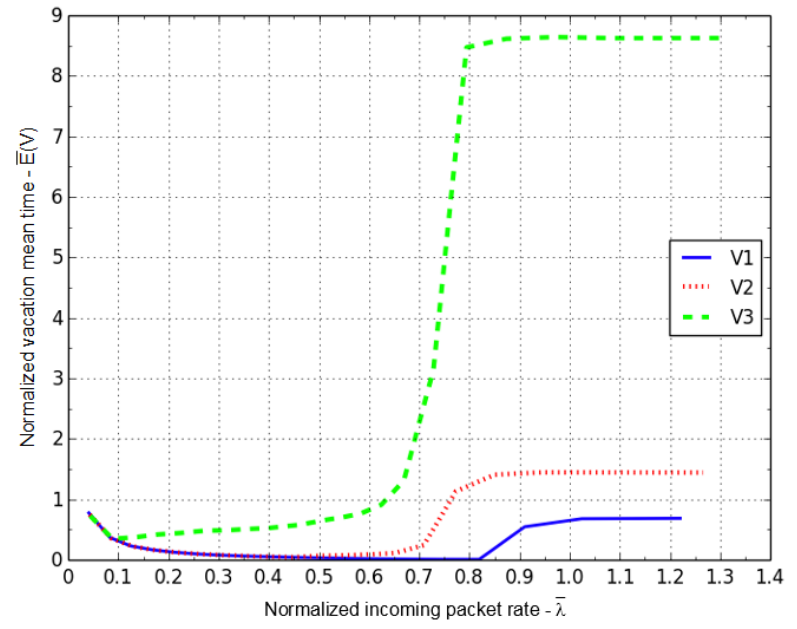
Figure 6. Evaluation scenarios: V1, V2, and